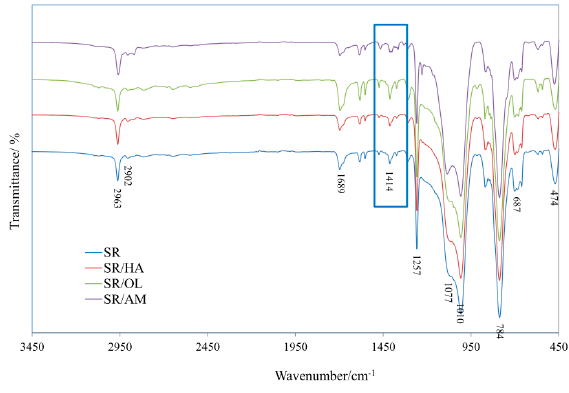
Figure 7. FTIR spectra of SR/POSS composites.